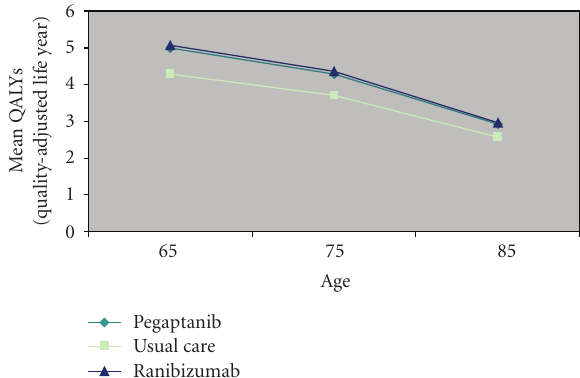
Figure 3: Net health benefits accruing to patients with neovascular age-related macular degeneration when using vascular endothelial growth factor inhibitors according to annual risk of a cardiovascular (CV)